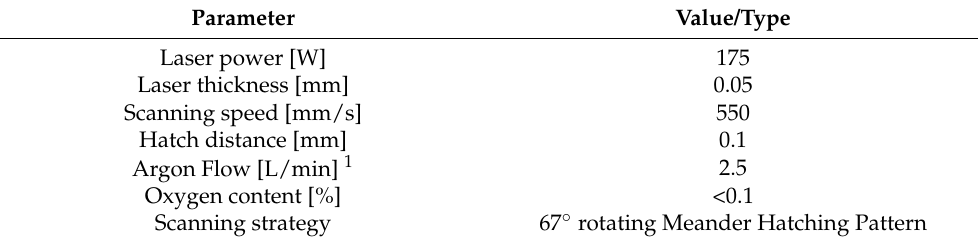
Table 6. Printing parameters adopted for the realization of the functional model made of AISI 316L stainless steel with the 3D SLM-based printer SLM500—SLM Solutions Group AG by ZARE S.r.l. 3D printing service.